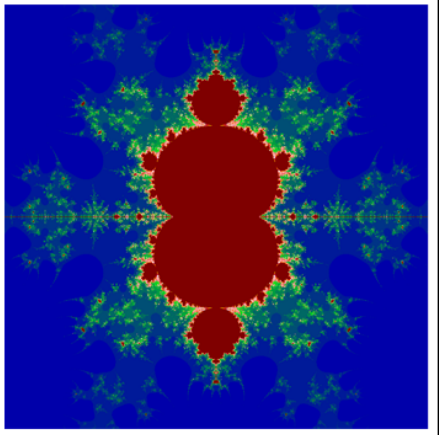
Figure 42. M-set via F-iteration sin ( z 3 ) + c with image visual time = 155.4 s.